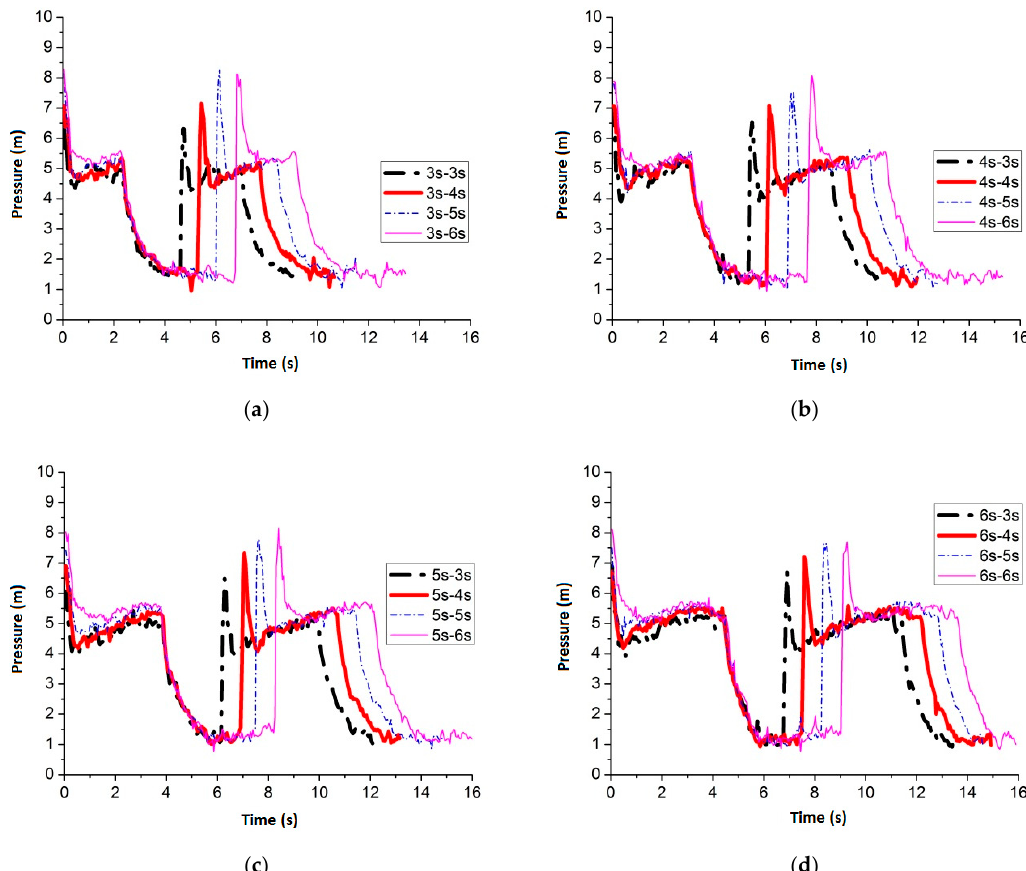
Figure 12. Pressure fluctuation of No. 1 sensing point (rectangular nozzle in the middle of the pipe): ( a ) air inflow time is 3 s; ( b ) air inflow time is 4 s; ( c ) air inflow time is 5 s; and ( d ) air inflow time is 6 s.